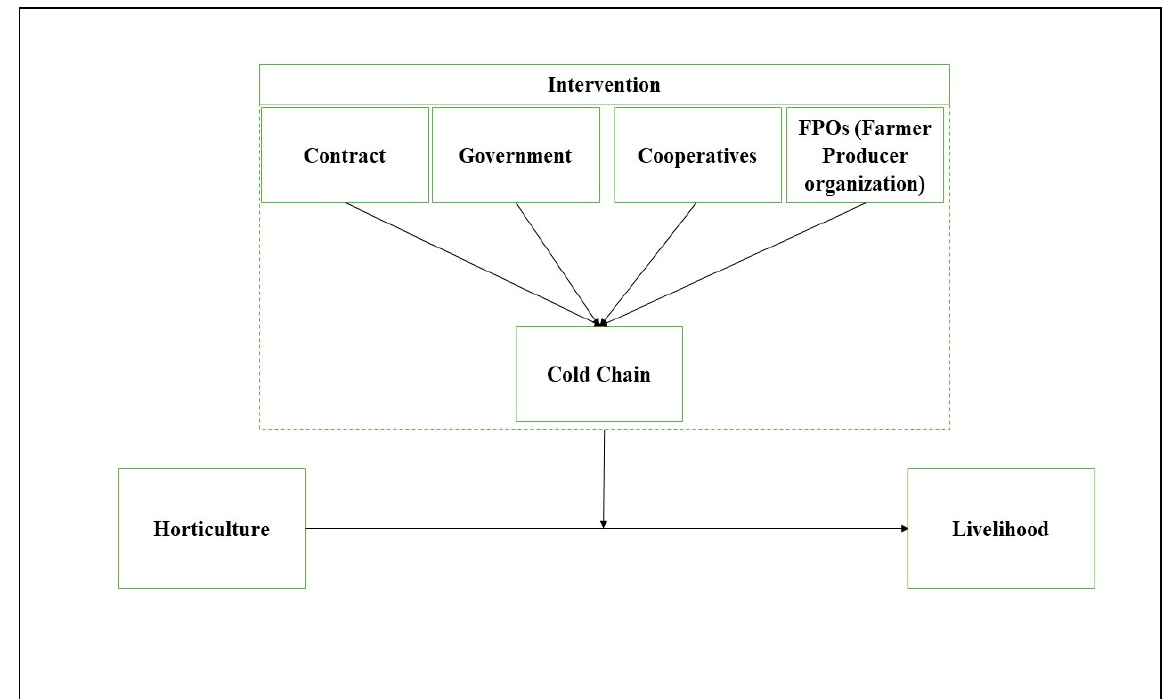
Figure 3. Context, Future Direction, and Outcomes, Source: The Authors.